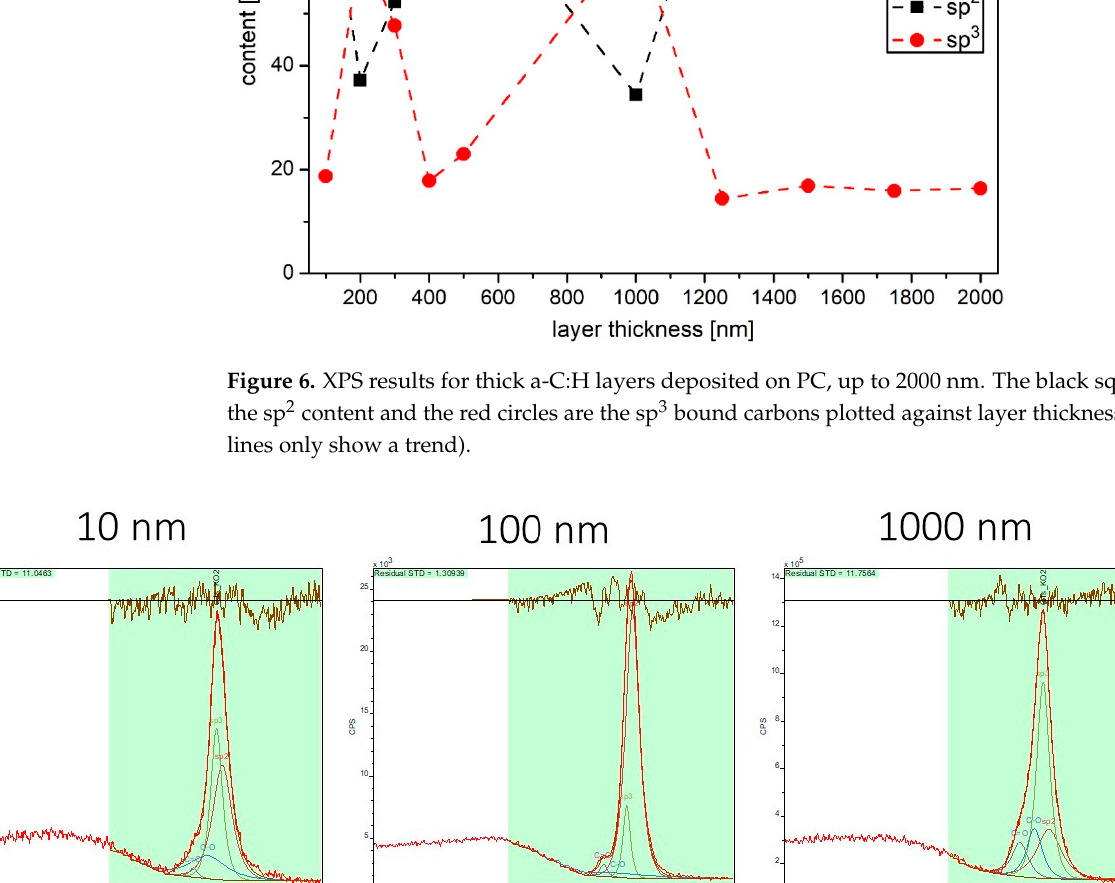
Figure 7. Exemplary XPS peak deconvolution for the a-C:H layer thicknesses of 10, 100 and 1000 nm. The analysis was performed on the sp 2 , sp 3 , C-O and C=O fractions using CasaXPS software.